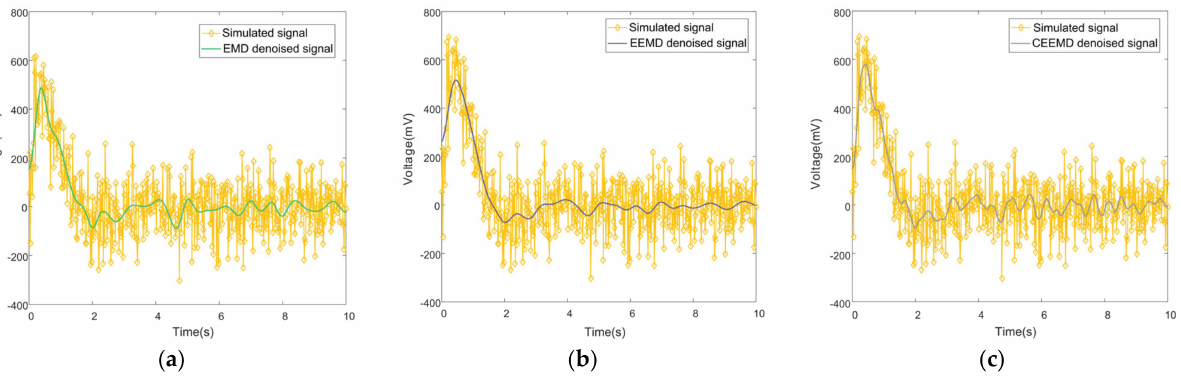
Figure 9. Time domain diagram of the simulated signal before and after denoising: ( a ) EMD; ( b ) EEMD; ( c )